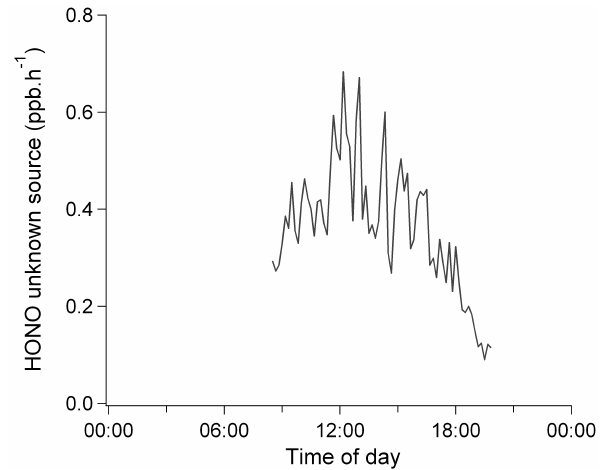
Fig. 10. Mean diurnal profile of the unknown HONO source cal- culated using Eq. (3), during MEGAPOLI summer campaign at SIRTA observatory (local